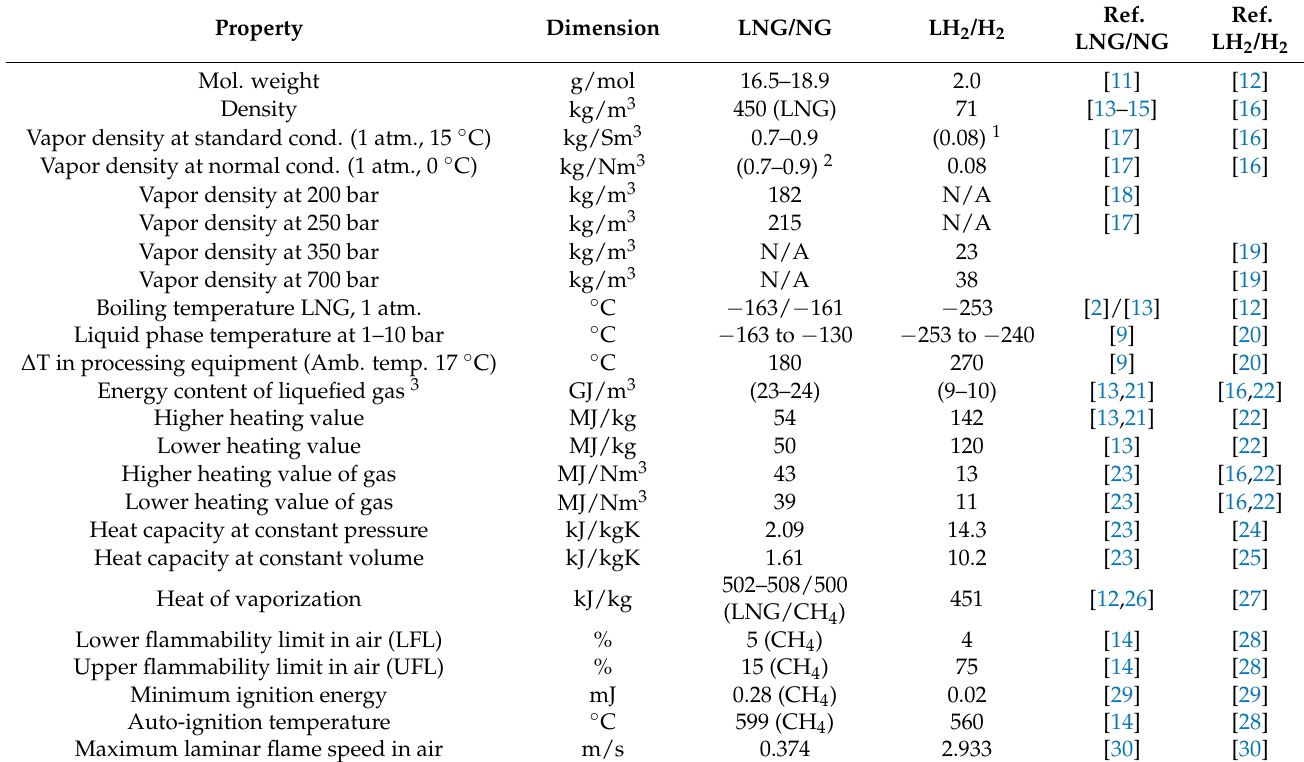
Table 1. Overview of selected properties of liquefied natural gas (LNG), natural gas (NG), liquefied hydrogen (LH 2 ) and compressed hydrogen (CH 2 ) with references. Data for methane (CH 4 ) has been added where reliable LNG/NG data could not be